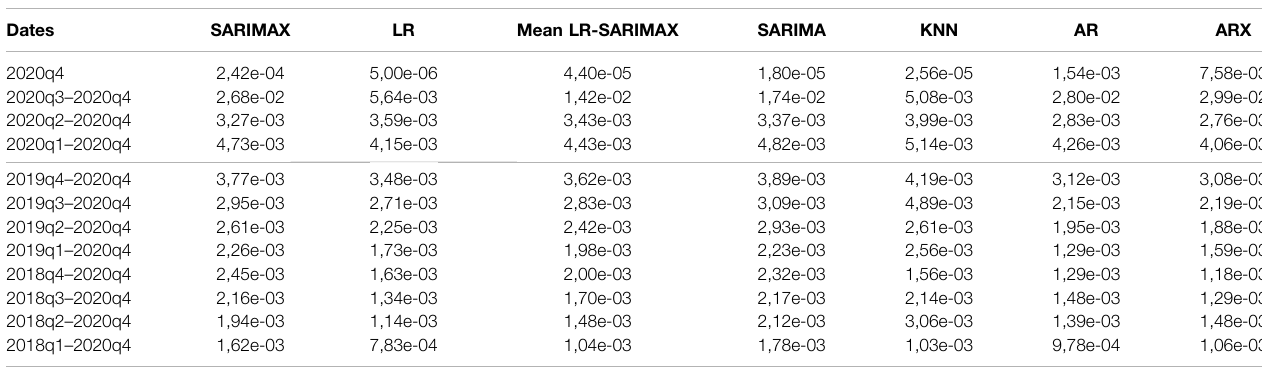
TABLE 4 | MSE multi-step-ahead forecast, Scenario 5.